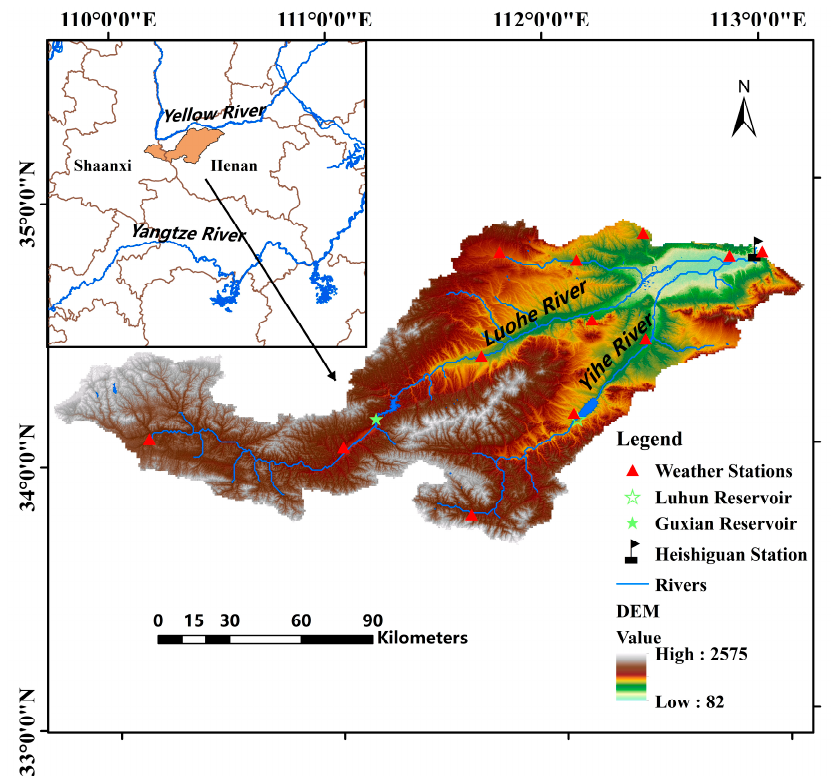
Figure 1. Study area with weather stations, reservoirs, and watershed outlets.